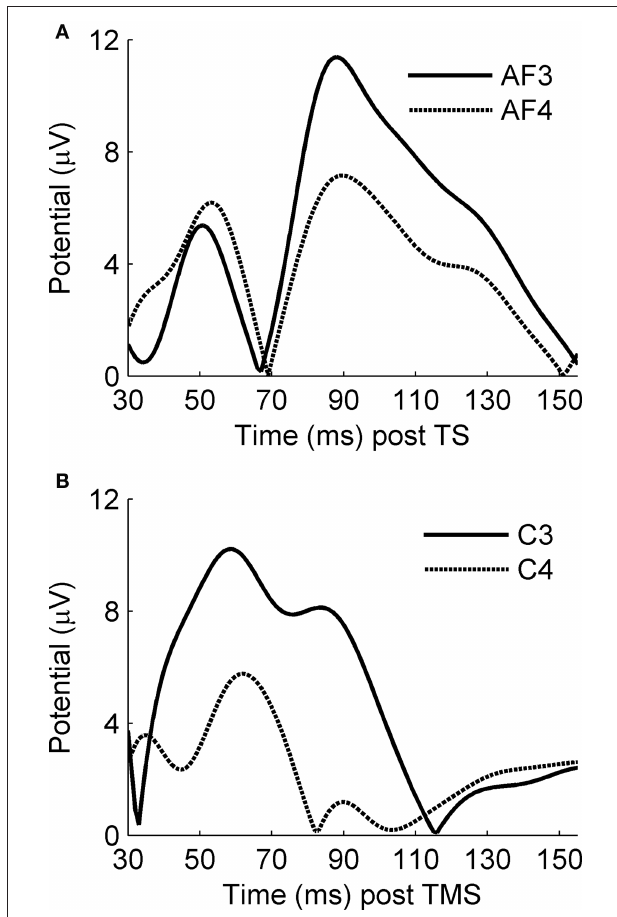
FIguRE 2 | Cortical evoked potentials in ipsi- and contralateral hemispheres following the application of TMS to the left DLPFC and left motor cortex. The waveforms represent mean rectified cortical potentials following the delivery of single pulse of TMS to the left DLPFC (A) and the left motor cortex (B) . In both figures, x-axis represents the time after the delivery of the TMS, and the y-axis represents the cortical evoked potentials (mV). These figures illustrate that application of single pulse TMS to the left hemisphere (solid waveforms) results in cortical evoked potentials in the contralateral hemisphere (dashed waveforms), that are of lower amplitude than the cortical evoked potential in the ipsilateral